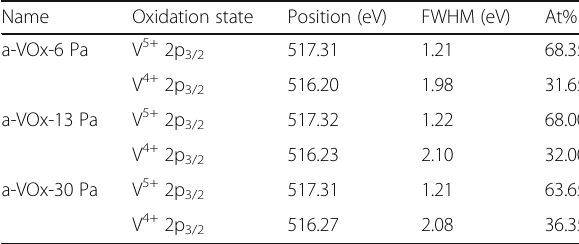
Table 2 XPS analysis of V 2p 3/2 in a-VOx thin films